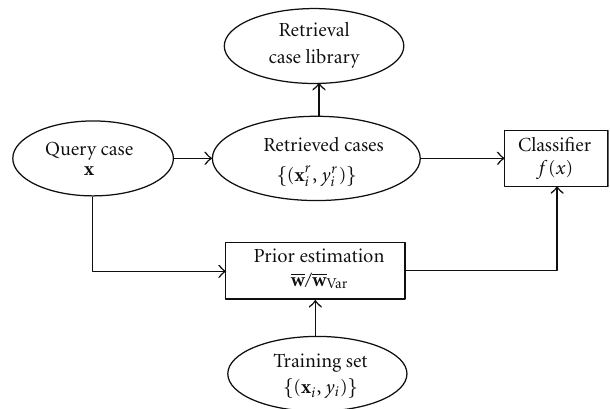
Figure 2: Diagram of retrieval-driven case-adaptive classification with